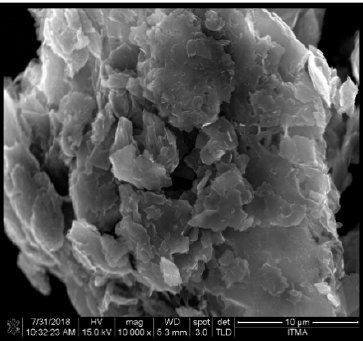
Figure 1. Field-emission scanning electron microscopy (FE–SEM) image of graphene nanoplatelets